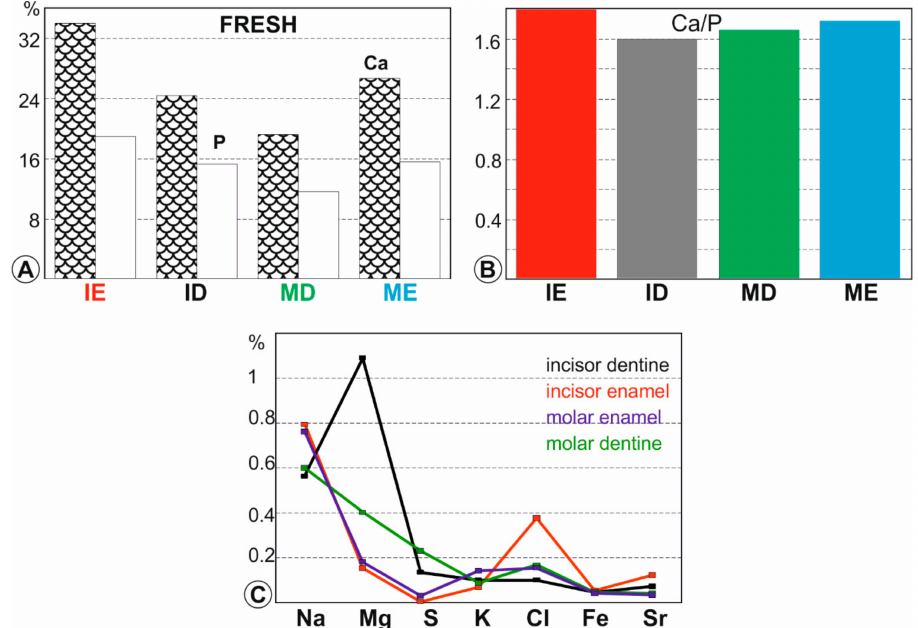
Figure 4. Chemical composition of fresh teeth. ( A )—Average major elements (P and Ca) contents; ( B )—Average Ca / P ratios; ( C )—Average minor element contents. ME: molar enamel, IE: incisor enamel, MD: molar dentine, ID: incisor dentine.